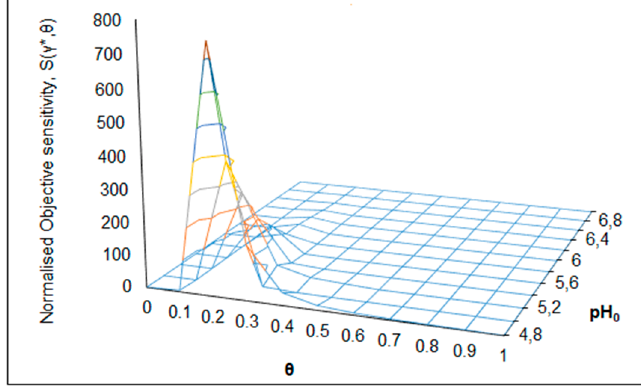
Figure 7. Normalized objective sensitivity S( γ *, θ ) as a function of parameters R and θ .